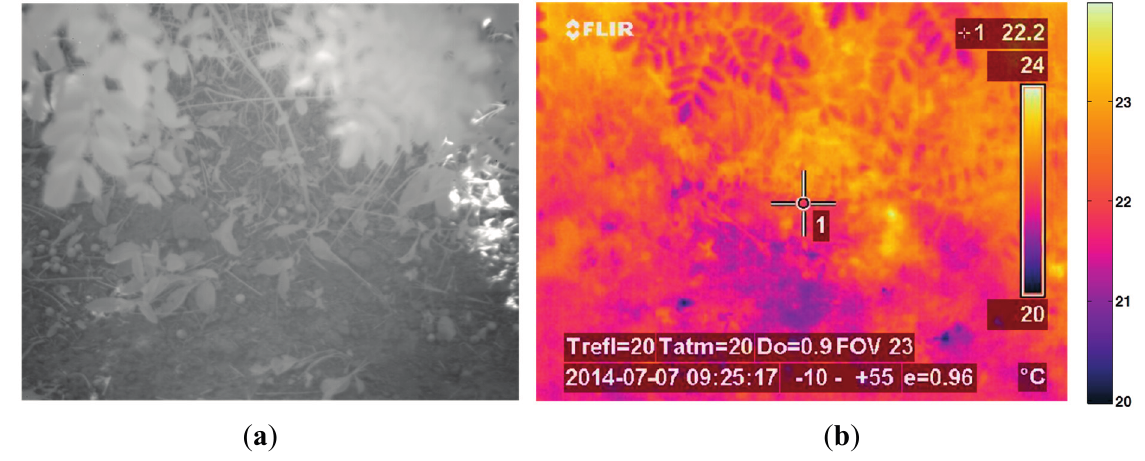
Figure 17. ( a ) Normalised SWIR image; ( b ) LWIR thermal image.